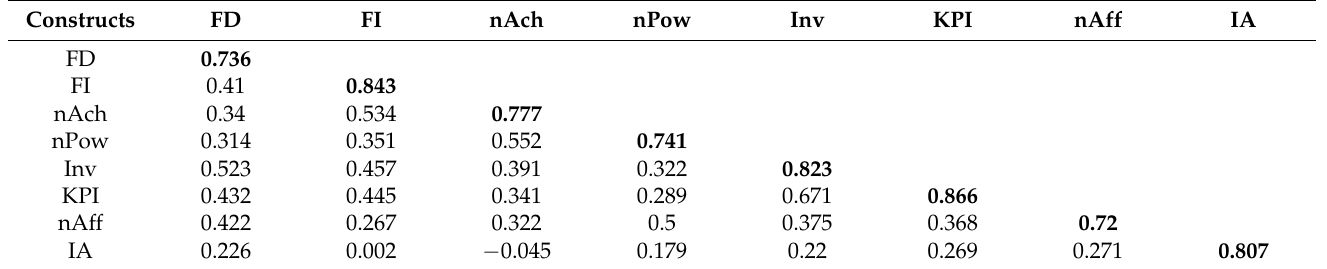
Table 4. The discriminant